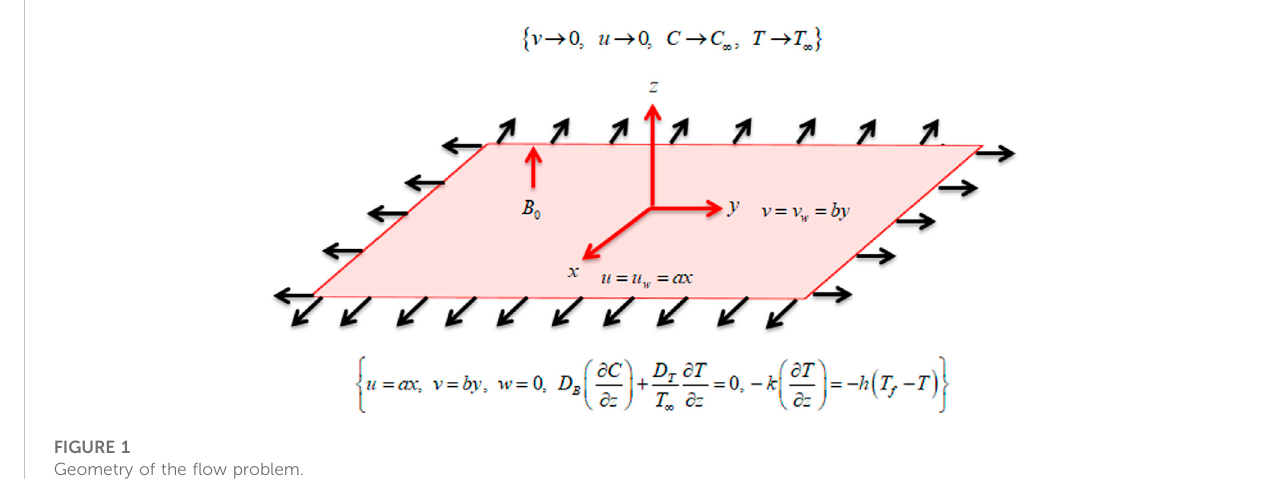
FIGURE 1 Geometry of the fl ow